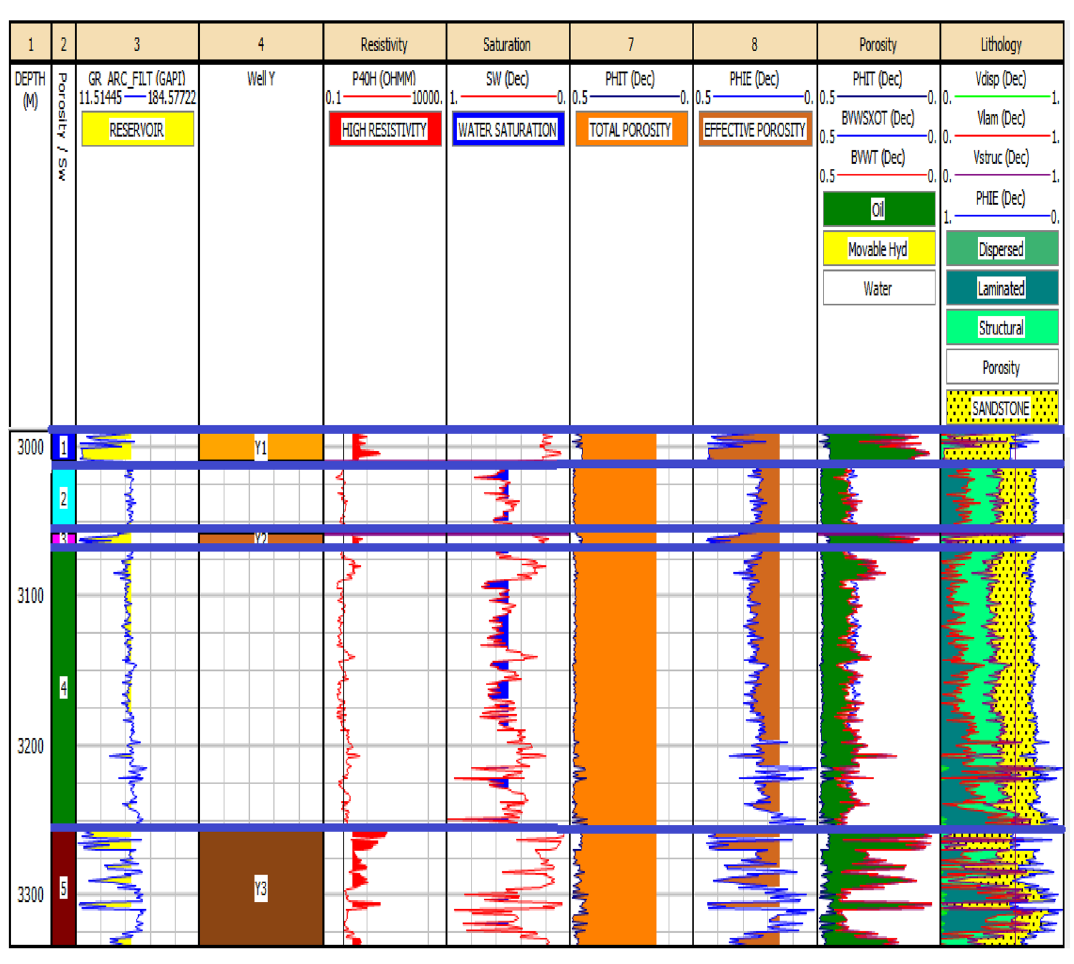
Fig. 6 Well Y reservoirs (Y 1 , Y 2 and Y 3 ) with estimated water saturation volume of shale, porosities and fluid types